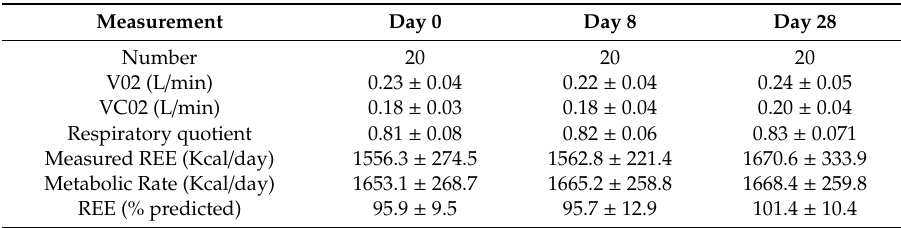
Table 3. Indirect calorimetry